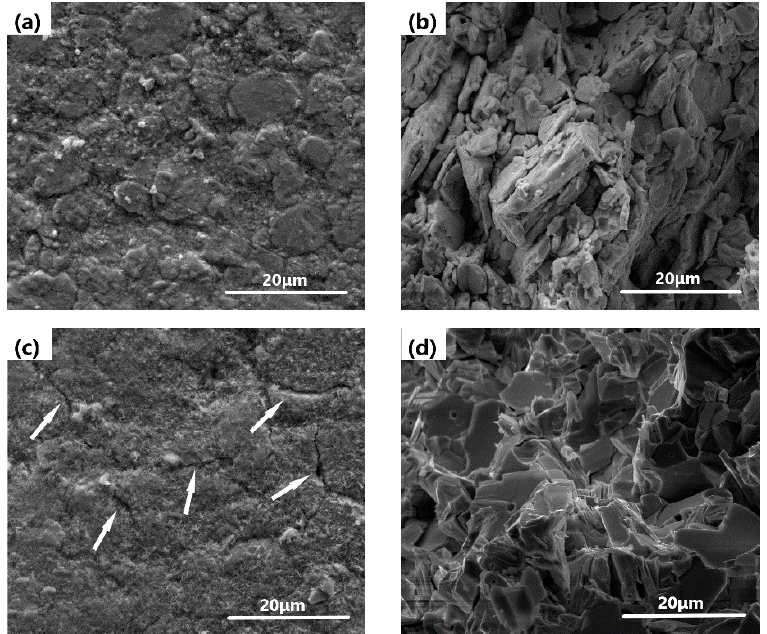
Figure 8. SEM micrographs and fracture images of 3 wt.% Bi 2 O 3 -97 wt.% PbO sintered at ( a , b ) 570 °C, and ( c , d ) 670 °C.